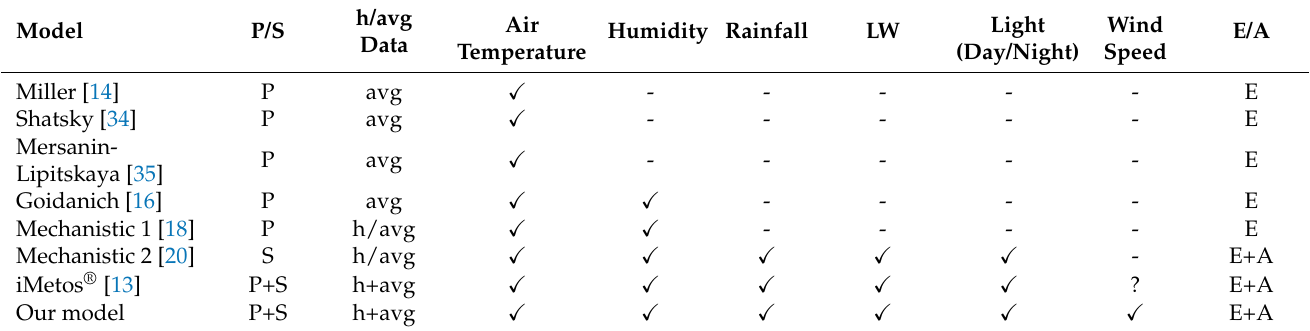
Table 4. Features comparison of different